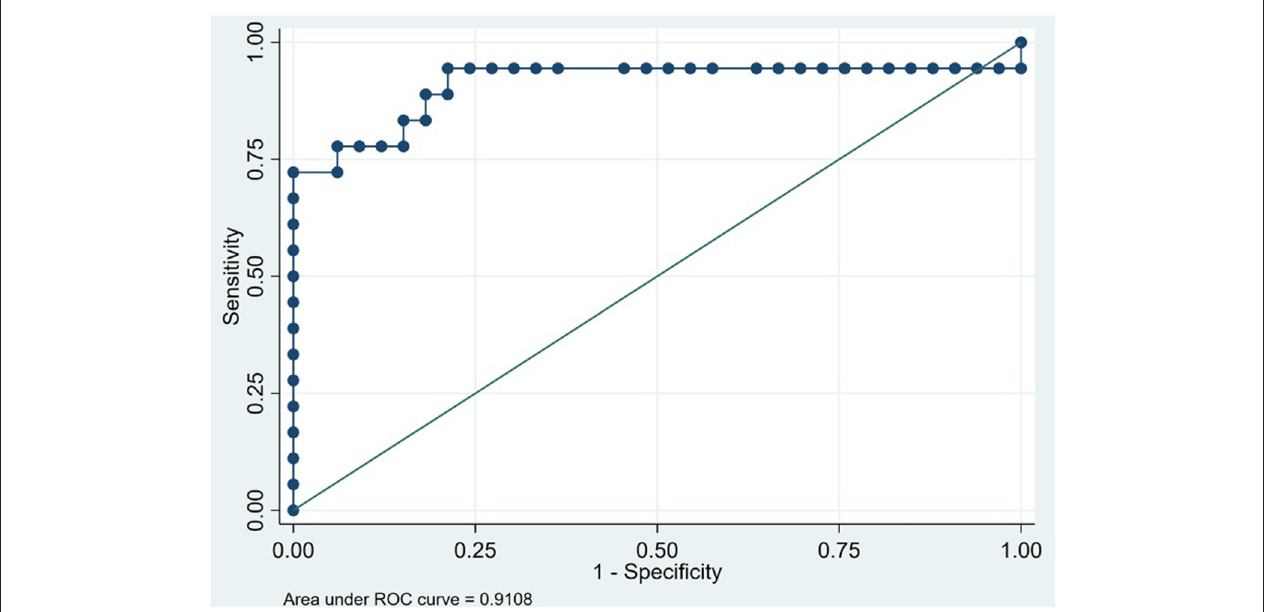
FIGURE 1 | Receiver operating characteristic curve for the Addenbrooke’s Cognitive Examination plus the INECO frontal screening in 51 patients to discriminate between behavioral variant frontotemporal dementia and Alzheimer’s disease (Instituto Peruano de Neurociencias, Lima, Peru; 2017–2020).